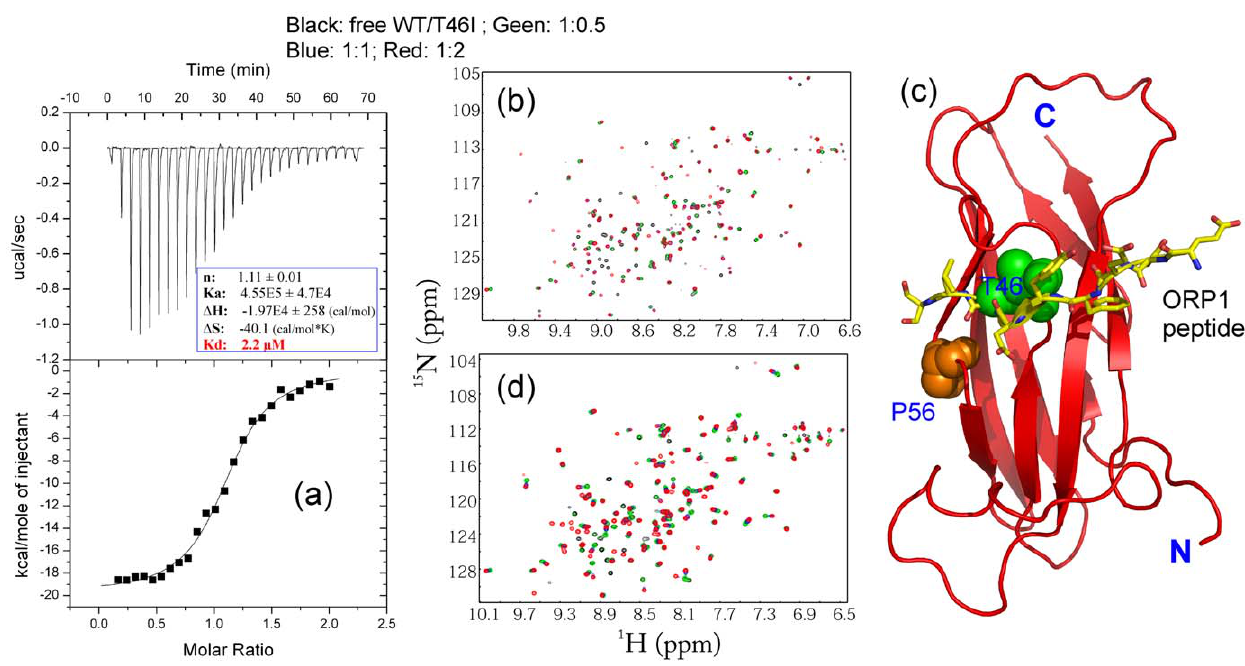
Figure 3. Interaction between the T46I-MSP domain and the Nir2 peptide. (a). The ITC titration profile of the binding reaction of the T46I- MSP domain to the Nir2 peptide [upper panel]; and integrated values for reaction heats with subtraction of the corresponding blank results normalized by the amount of ligand injected versus molar ratio of MSP/Nir2 (lower panel). Thermodynamic binding parameters obtained from fitting the data are shown in the box. Superimposition of the two-dimensional 1 H- 15 N NMR HSQC spectra of the WT- (b) and T46I- (d) MSP domains in the absence (black) and presence of the Nir2 peptide at molar ratios 1:0.5 (green), 1:1 (blue) and 1:2 (red). (c). Crystal structure of the VAPA MSP-ORP1 complex to illustrate the MSP-peptide binding interface [12].